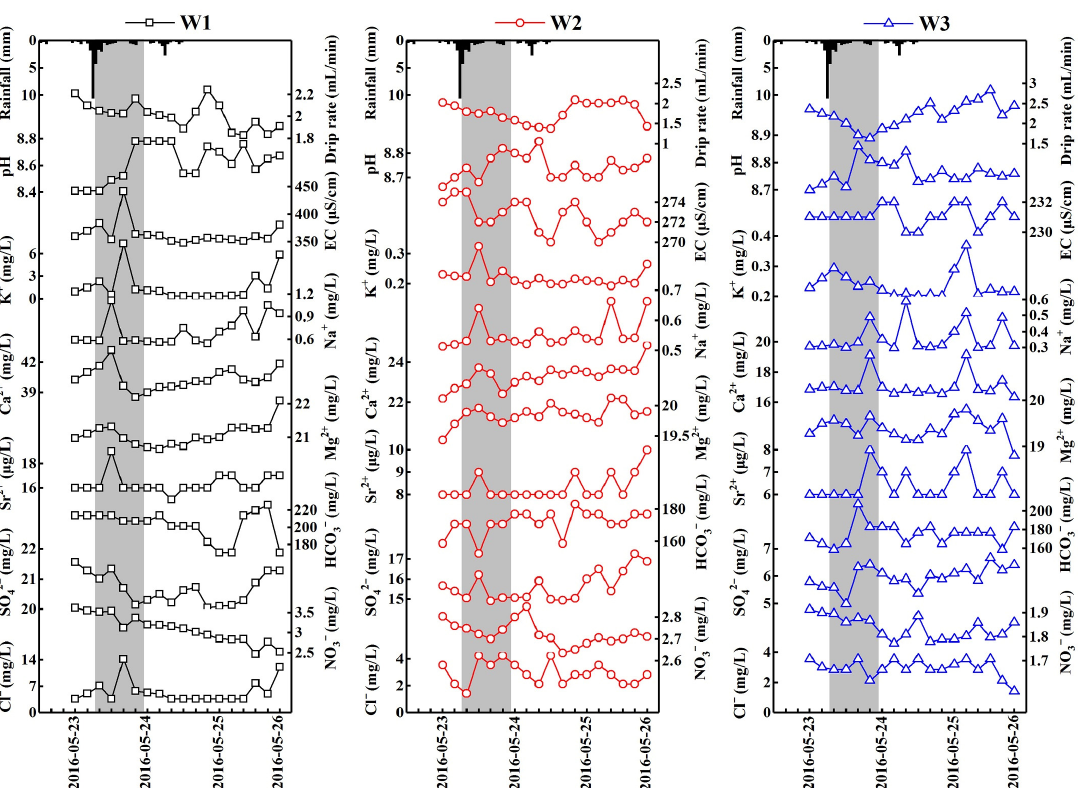
Figure 3. Variations of hydrogeochemical characteristics and the responses of drip rate to precipitation for three drip sites during precipitation